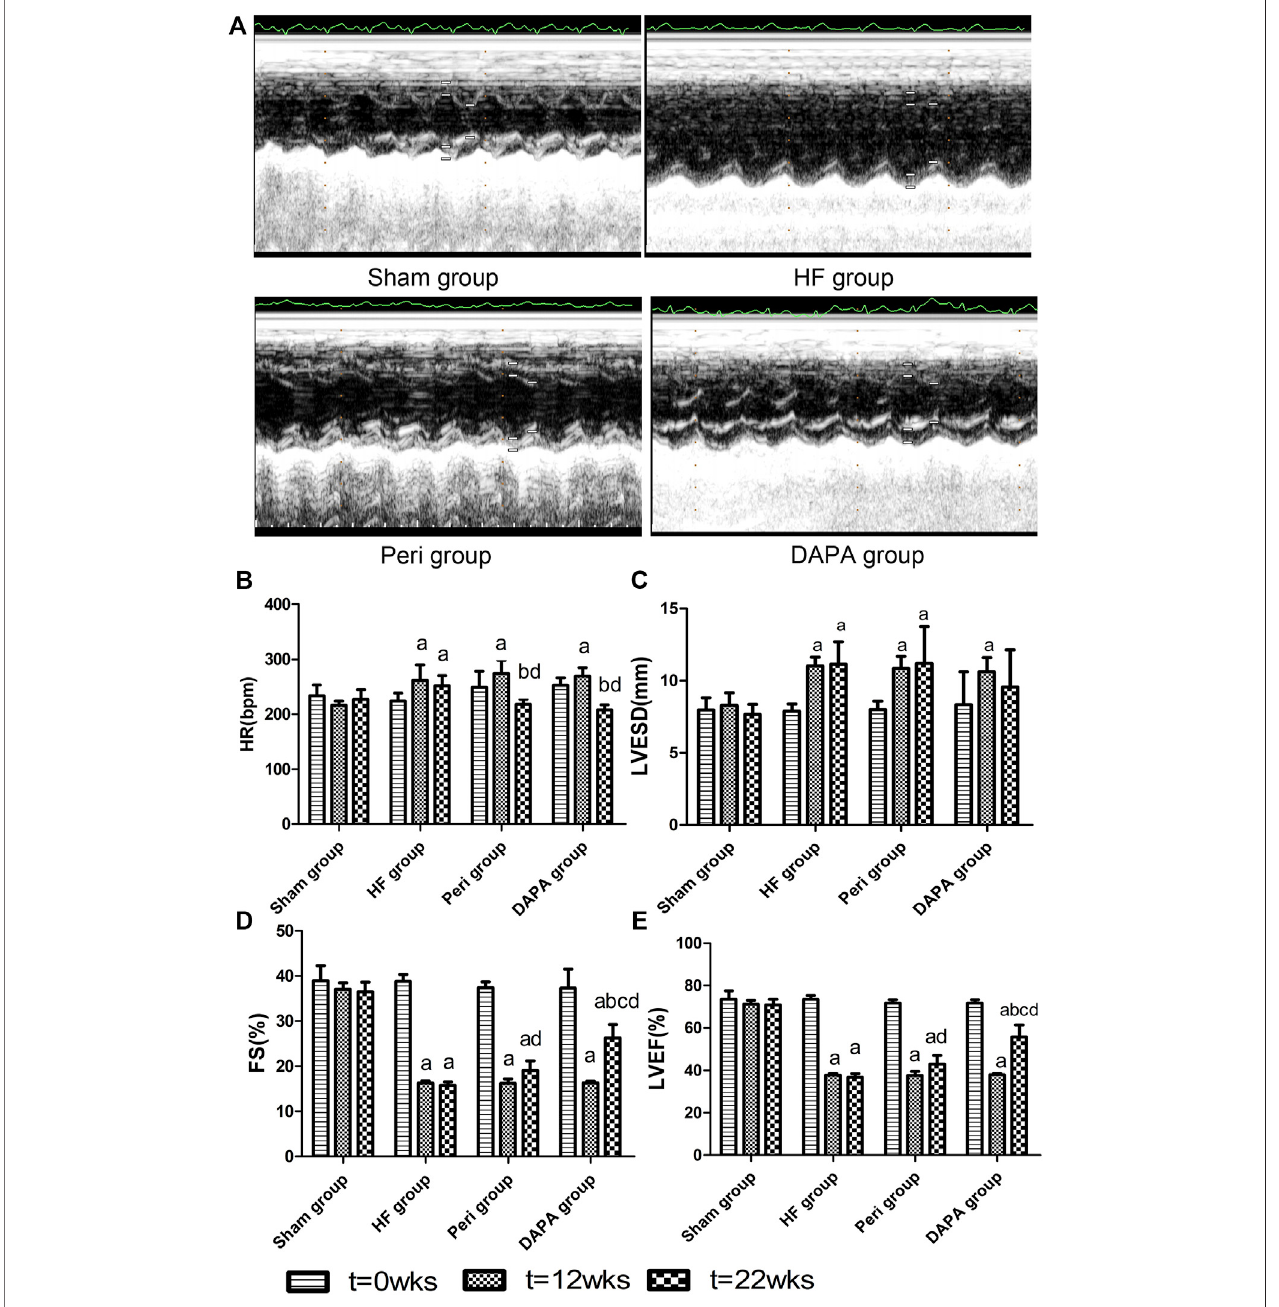
FIGURE 2 | Echocardiographic representative images after drug treatment by M-mode and (A) comparison of HR and (B) echocardiographic data of the left ventricle (C – E) . a p < 0.05 vs. the sham group; b p < 0.05 vs. the HF group; c p < 0.05 vs. the Peri group; d p < 0.05 vs. the counterpart data of the 12th week.